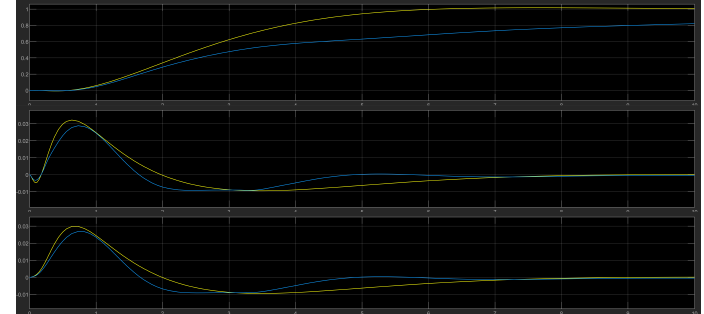
Figure 18. Comparison of the LQR (yellow) and FLC (light blue) for θ 0 , θ 1 and θ 2 .